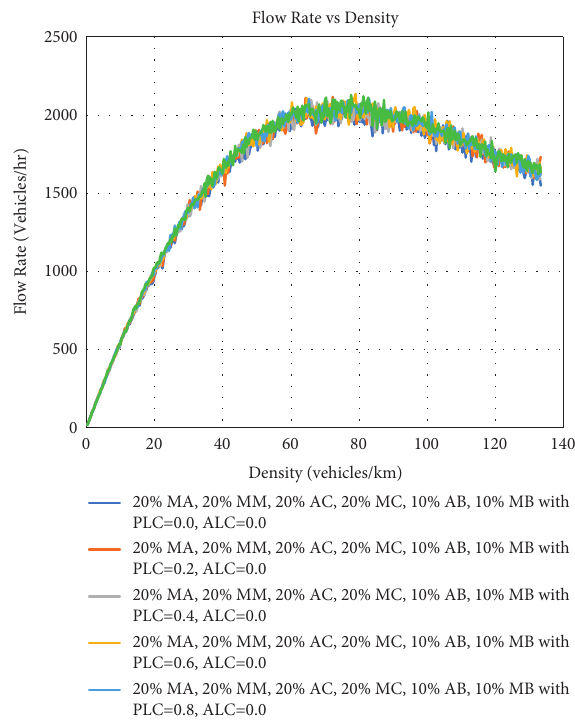
Figure 8: Flow rate vs. density fundamental diagrams for different compositions of MA, MM, AC, MC, AB, and MB with different values of PLC when ALC is fixed at